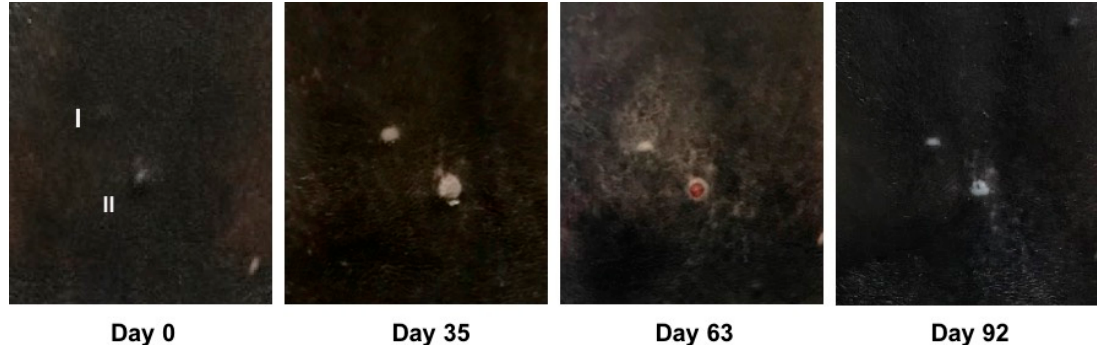
Figure 4. Clinical changes in melanoma I and II in horse 6 over time. The clinical changes in melanoma I and melanoma II (as indicated) on days 0, 35, 63 and 92 of the study. The tumors were treated twice a day with the 1% BA preparation (in “Basiscreme DAC” + 20% medium-chain triglycerides). In addition to the depigmentation of both tumors, an ulceration of melanoma II was occasionally observed from day 43 to day 70. Tumor volumes decreased from 63 mm 3 (melanoma I) and 63 mm 3 (melanoma II) on day 0 to 18 mm 3 (melanoma I) and 32 mm 3 (melanoma II) on day 92.